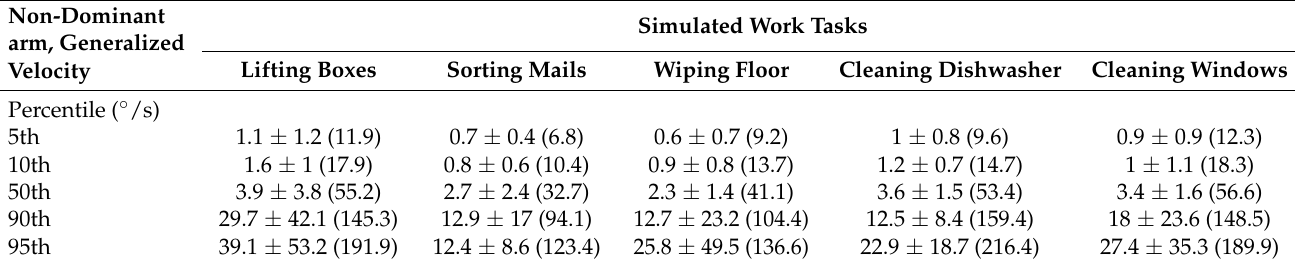
Table A4. The mean ± standard deviation of the mean absolute errors (MAEs) of the non-dominant arm generalized velocity between cloth sensors and skin sensors during the five simulated tasks, with the reference value of skin sensors shown in brackets ( n =